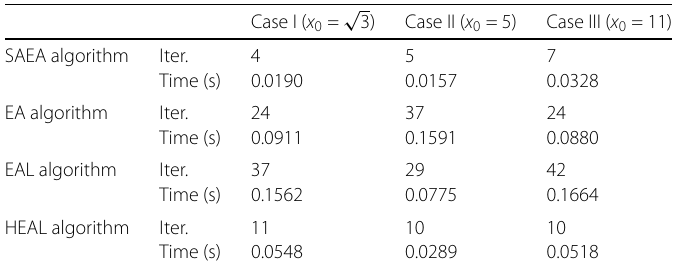
Table 1 Computational result for Example 4.1